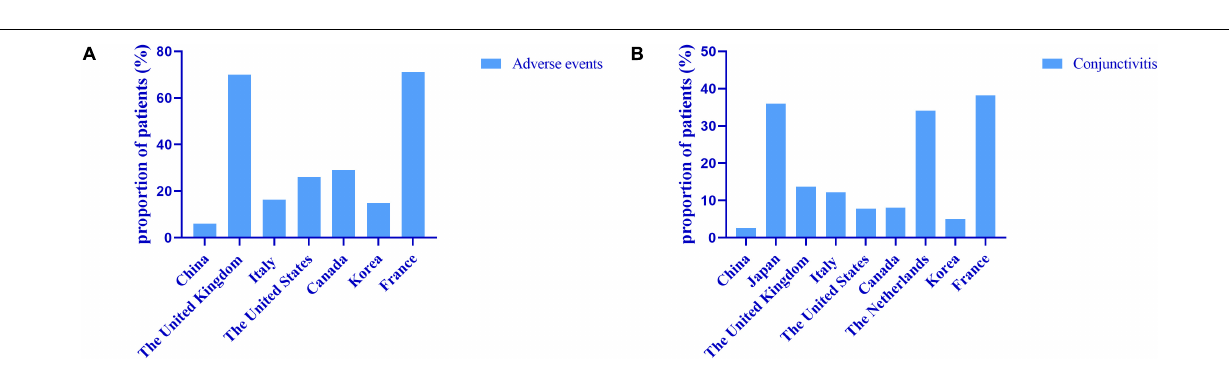
FIGURE 5 | Real world data on adverse events (A) and conjunctivitis (B) from different countries. The reported rates of adverse events in other countries are higher than those in the Chinese population, especially for